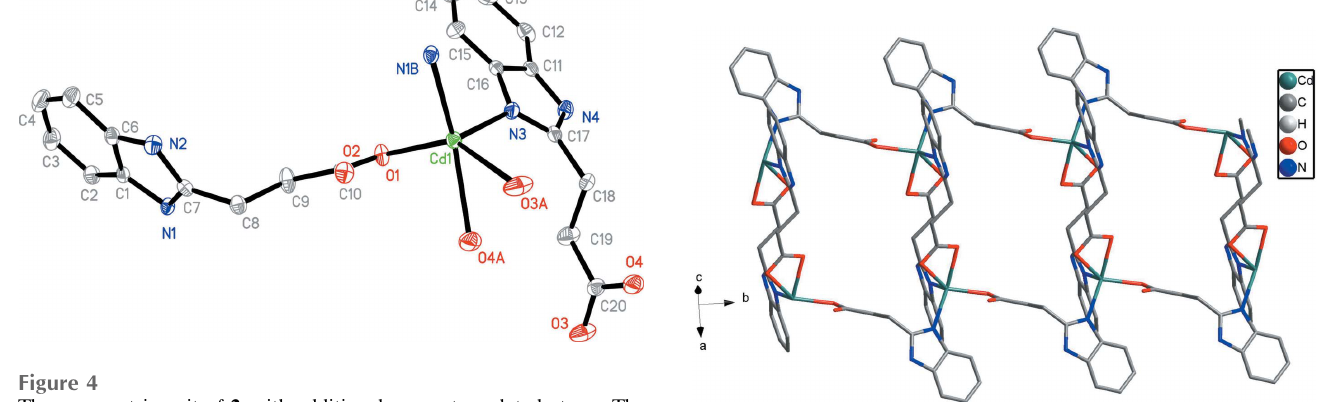
Figure 5 A view of the one-dimensional ladders in 2